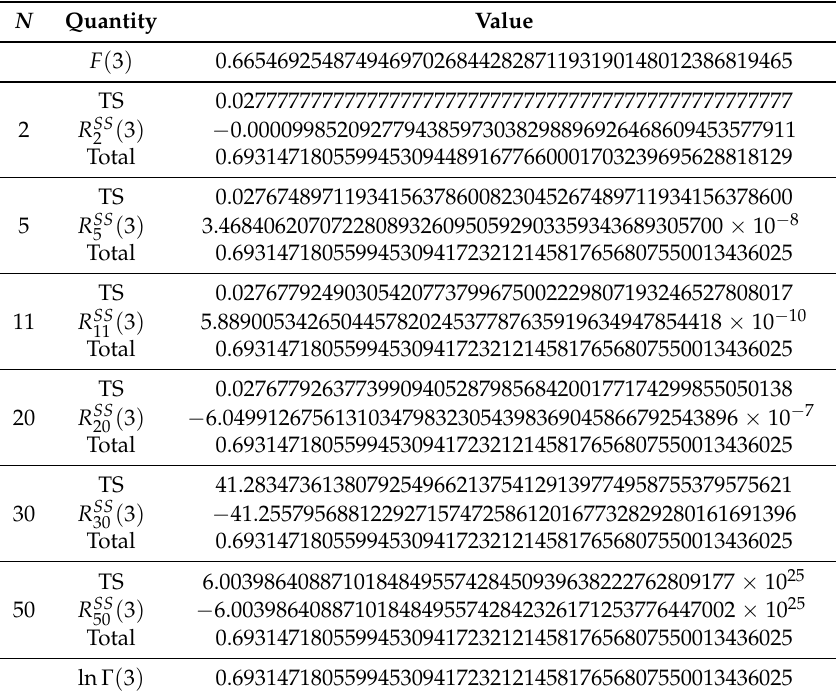
Table 1. ln Γ ( 3 ) via (35) for various values of the truncation parameter, N